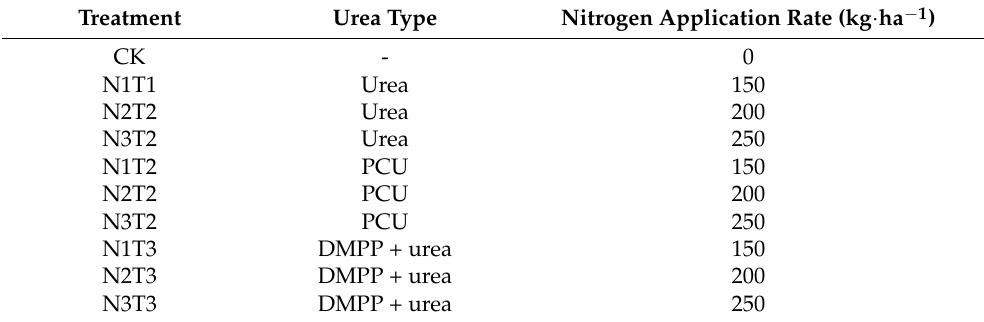
Table 1. Test factors and experimental design.